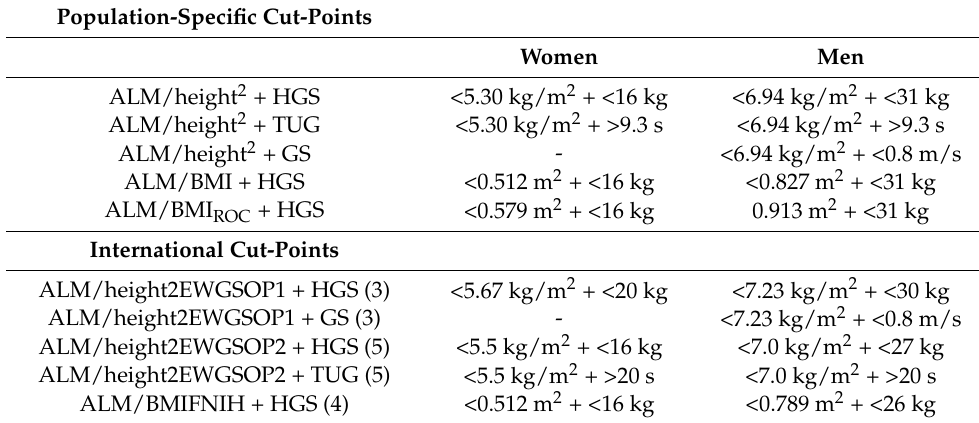
Table 1. Applied threshold values for women and men used in different definitions. Population-Specific